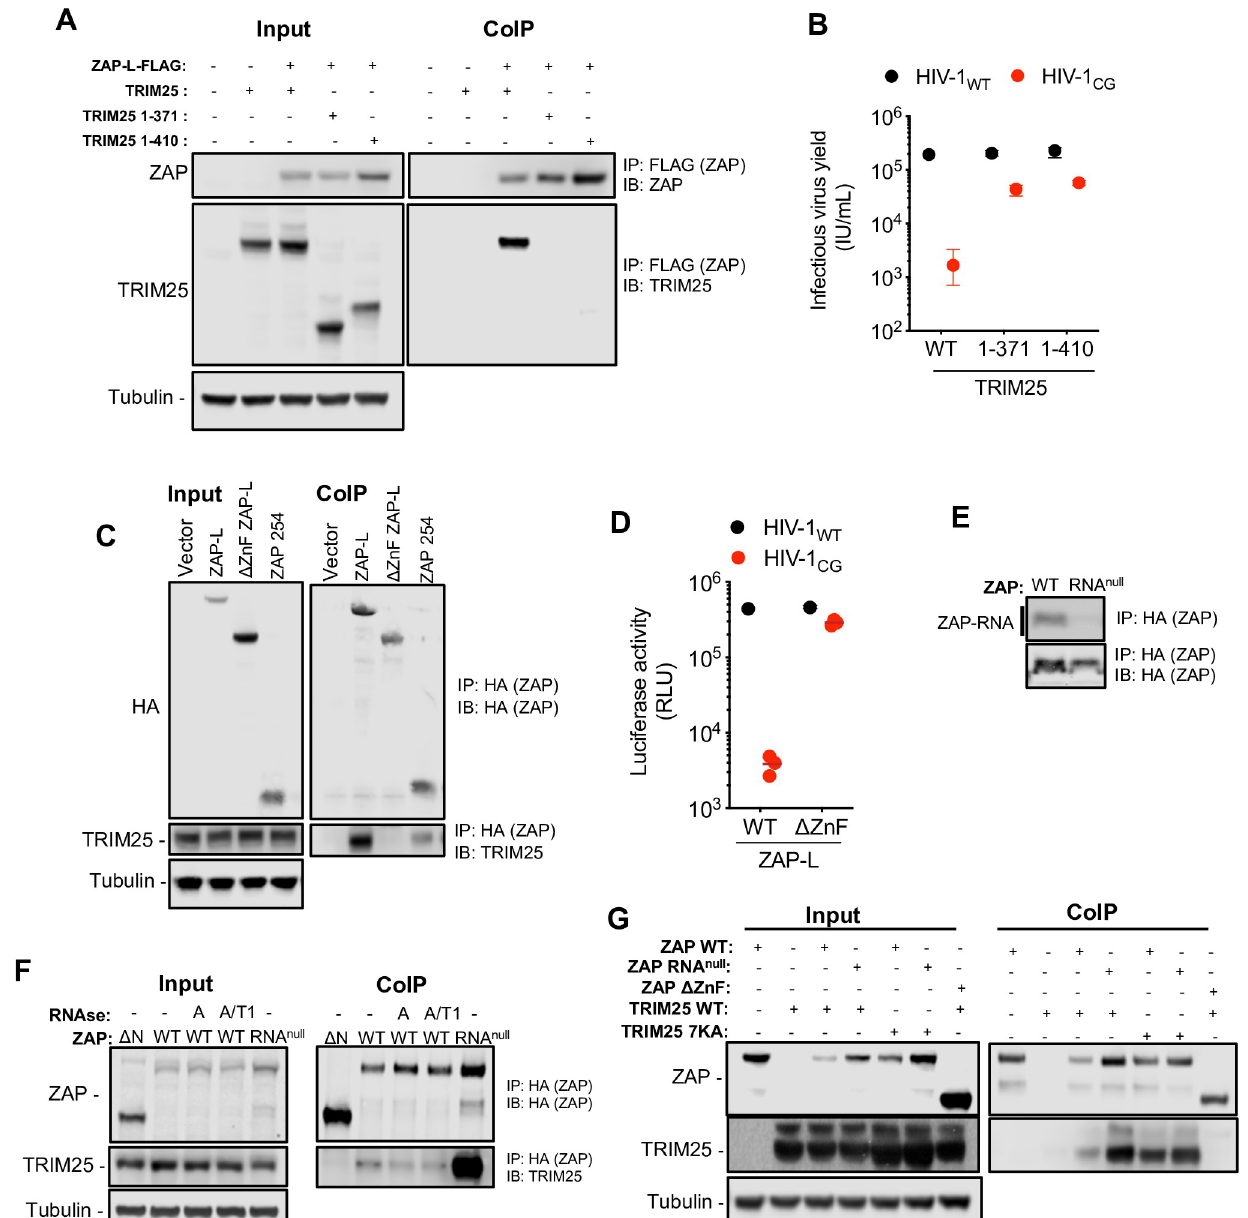
Fig 5. TRIM25 binds the ZAP NTD independently of RNA. (A) HEK293T ZAP -/- and TRIM25 -/- cells were co-transfected with plasmids expressing human ZAP-L-FLAG and full-length untagged human TRIM25 or one of two human TRIM25 truncations (corresponding to the N-terminal 371 or 410 amino acids of TRIM25), that lack the SPRY domain [21]. Proteins were immunoprecipitated from cell lysates with an anti-FLAG antibody and subjected to western blot analysis. IP, immunoprecipitation. IB, immunoblot. (B) HEK293T ZAP -/- TRIM25 -/- cells were co-transfected with proviral plasmids and plasmids encoding human ZAP and full-length TRIM25 or the indicated truncated TRIM25 proteins. Infectious virus yield was determined using MT4-R5-GFP target cells. (C) HEK293T ZAP -/- cells were transfected with an empty vector or plasmids encoding human ZAP-L-HA, a truncated ZAP lacking the RNA binding domain ( Δ ZnF ZAP-L) or a truncated ZAP comprising the N-terminal 254 amino acids (ZAP 254). Proteins were immunoprecipitated from cell lysates with an anti-HA antibody and analysed by western blotting to detect overexpressed ZAP-L-HA and endogenous TRIM25. (D) Antiviral activity of Δ ZnF ZAP-L was assessed by co-transfecting HEK293T ZAP -/- cells with indicated proviral plasmids and plasmids encoding full length (WT) or truncated ( Δ ZnF) human ZAP. Infectious virus yield was determined using MT4-R5-GFP target cells. (E) HEK293T ZAP -/- cells were transfected with plasmids encoding human ZAP-L (WT) or an RNA-binding mutant of ZAP (RNA null , R74A, R75A, K76A). After overnight incubation cells were irradiated with UV light, and ZAP proteins were immunoprecipitated. RNA bound to each protein was radiolabelled and protein- RNA adducts were resolved by SDS-PAGE, transferred to a nitrocellulose membrane and exposed to autoradiographic film. In parallel, a western blot of immunoprecipitated proteins was done using anti-HA antibody. IP, immunoprecipitation. IB, immunoblot. (F) HEK293T ZAP -/- cells were transfected